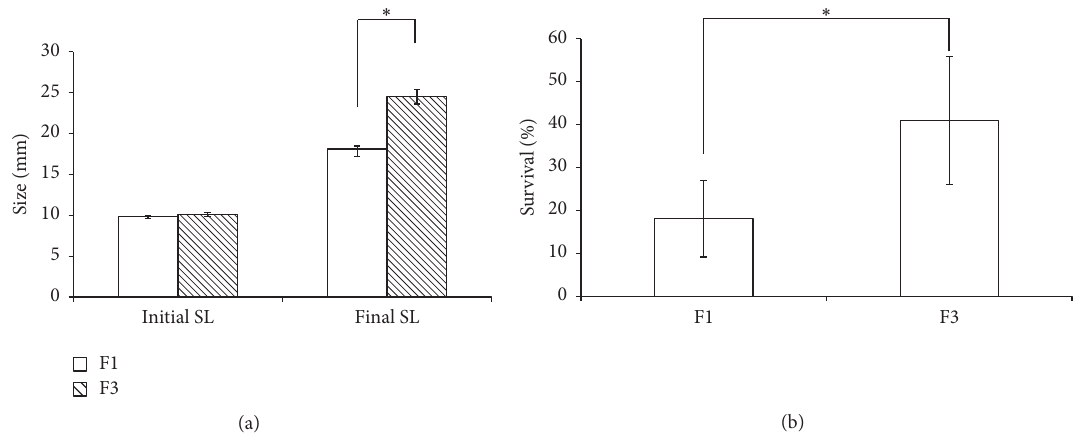
Figure 1: Growth and survival of inbred line of M. arenaria . (a) Size, measured in shell length (SL) (in mm, open bars) and growth, measured as mean final SL (in mm, diagonally hatched bars) in the F3 versus F1 Mya arenaria . Error bars represent 95% CI ( ∗ 𝑝 < 0.0001 ). Growth was 35.4% greater in the F3 versus F1 line. (b) Mean percent survival (open bars) in F3 versus F1 Mya arenaria . Mean percent survival was greater in the F3 versus F1 line by 126.4% ( ∗ 𝑝 = 0.011